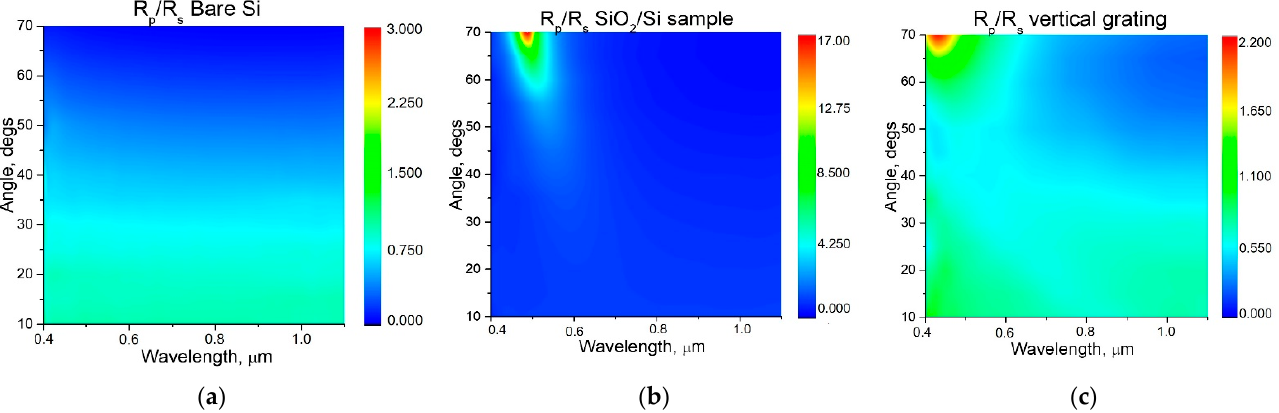
Figure 5. Map of R p /R s ratio of light reflection for bare Si with native oxide ( a ), flat oxidized Si substrate ( b ), and oxidized Si with vertically oriented LIPSS diffraction gratings ( c ).